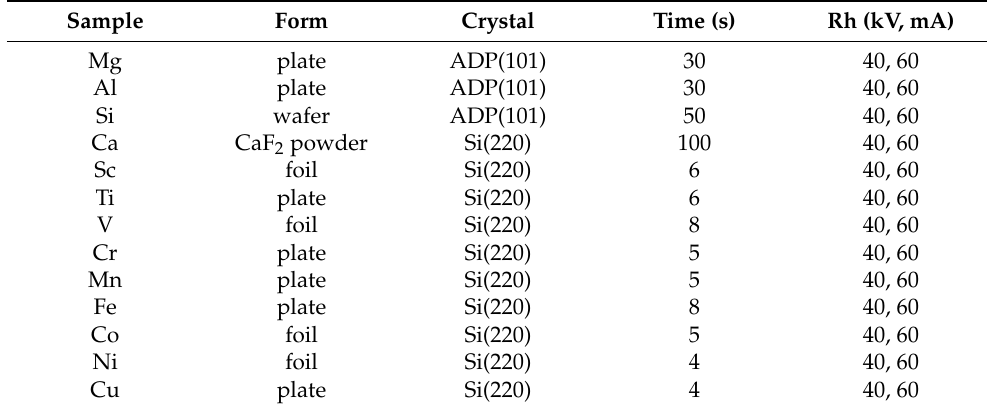
Table 6. Experimental conditions in the K α , β spectral lines measurements. In all cases, the step in 2 θ was 0.005°.